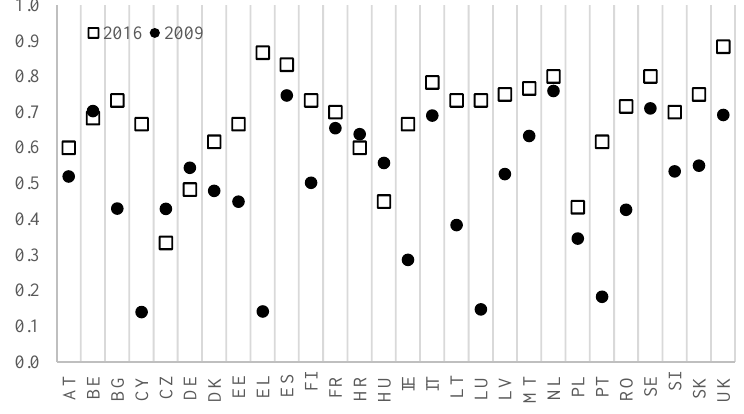
Figure 2. MTBFs indexes in 2009 and 2016